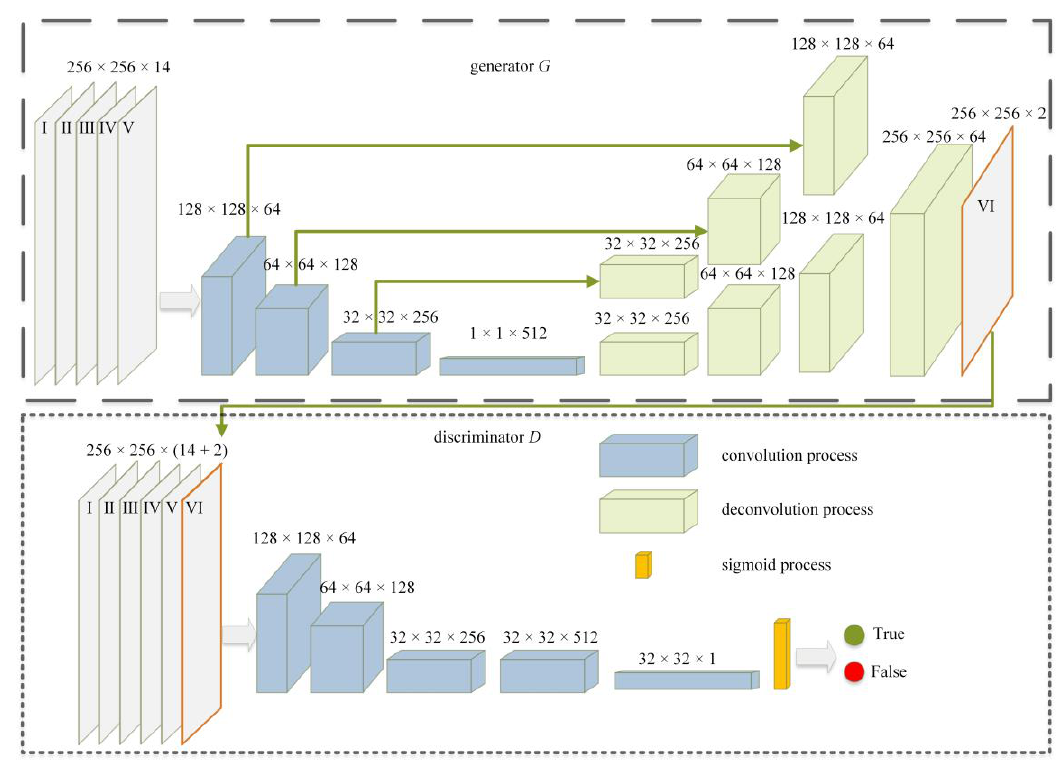
Figure 4. Intelligent generating model for cross sections. Ⅰ : Geological coding data. II: Gravity anomaly and continuation data. III : Aeromagnetic anomaly and continuation data. IV : Points of the known section polyline. V : Distance coefficient. VI : Points of generated section polyline.